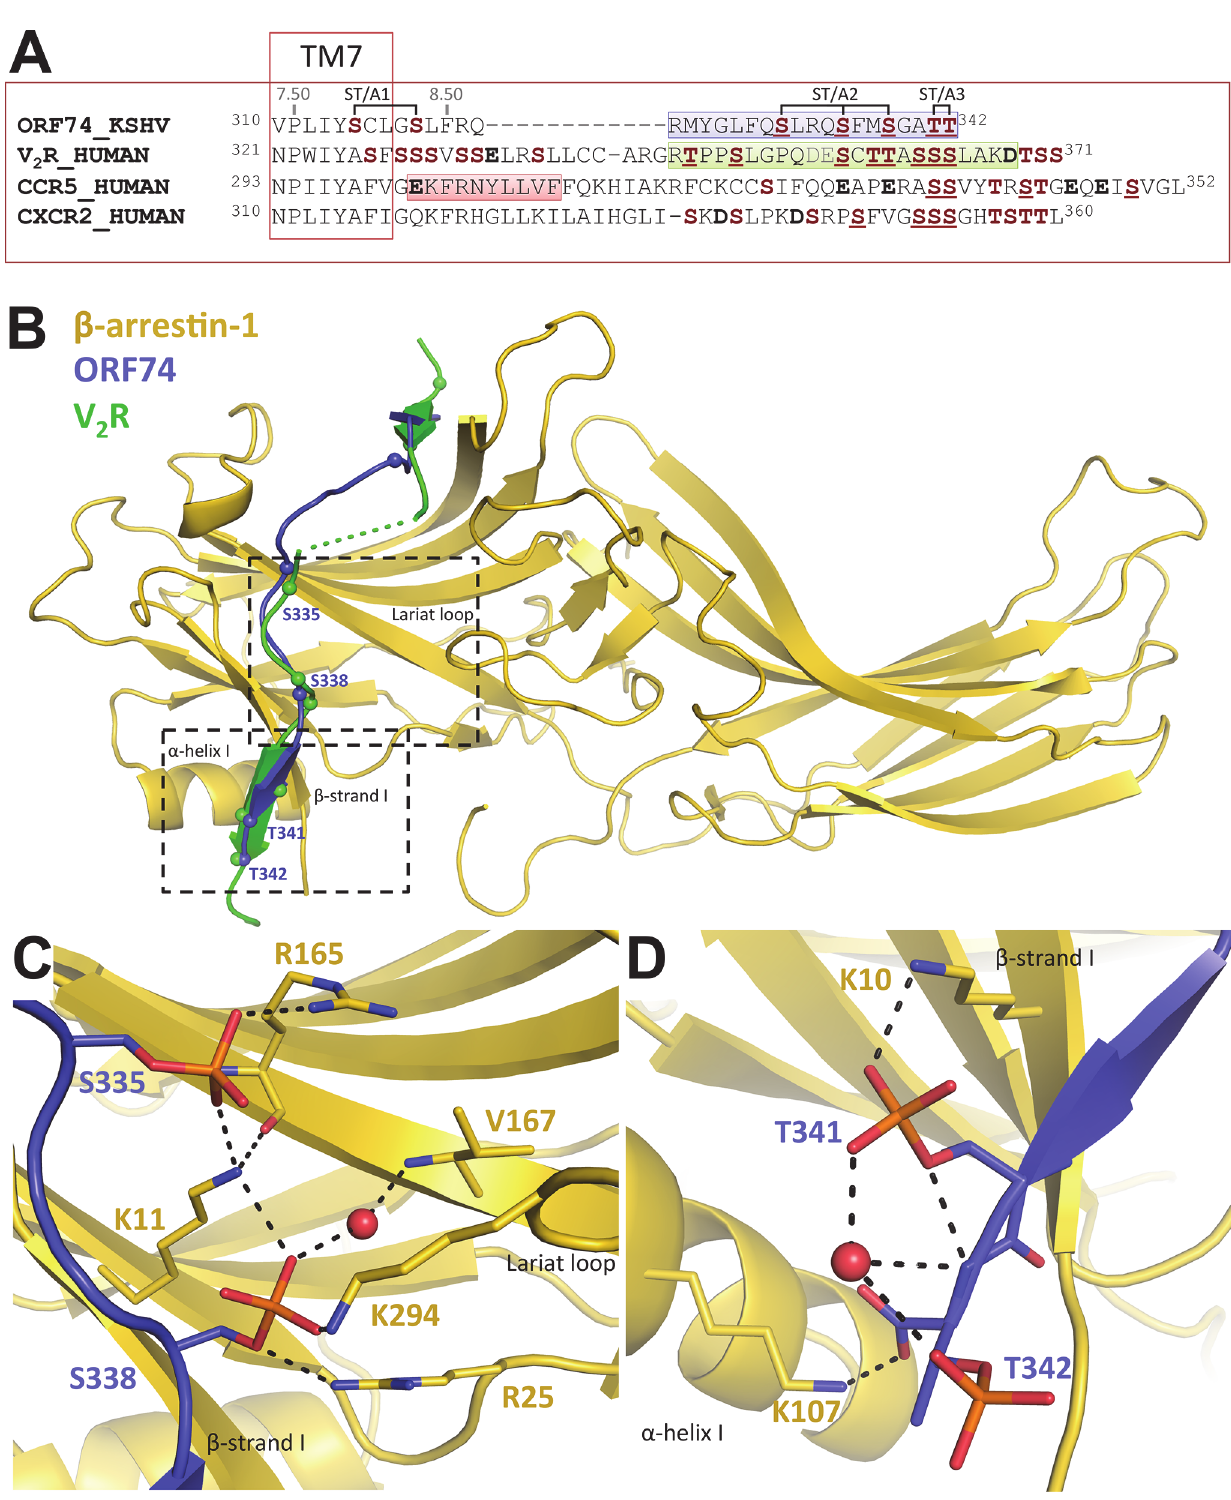
Fig 6. Homology model of the phosphorylated ORF74 C-tail bound to β -arrestin1. (A) Sequence alignment of V 2 R, CCR5, CXCR2, and ORF74 with a focus on serine (S) and threonine (T) residues (bold, brown) and aspartate (D) and glutamate (E) residues (bold). Underlined S/T residues are experimentally determined to be phosphorylated [37 – 45] or are phosphorylated in the active β -arrestin1 crystal structure [20]. The location of TM7 (delineated) and helix 8 (marked red) are based on the CCR5 crystal structure (PDB-code 4MBS) (35). Residues of the V 2 R-peptide solved in the active β -arrestin1 crystal structure